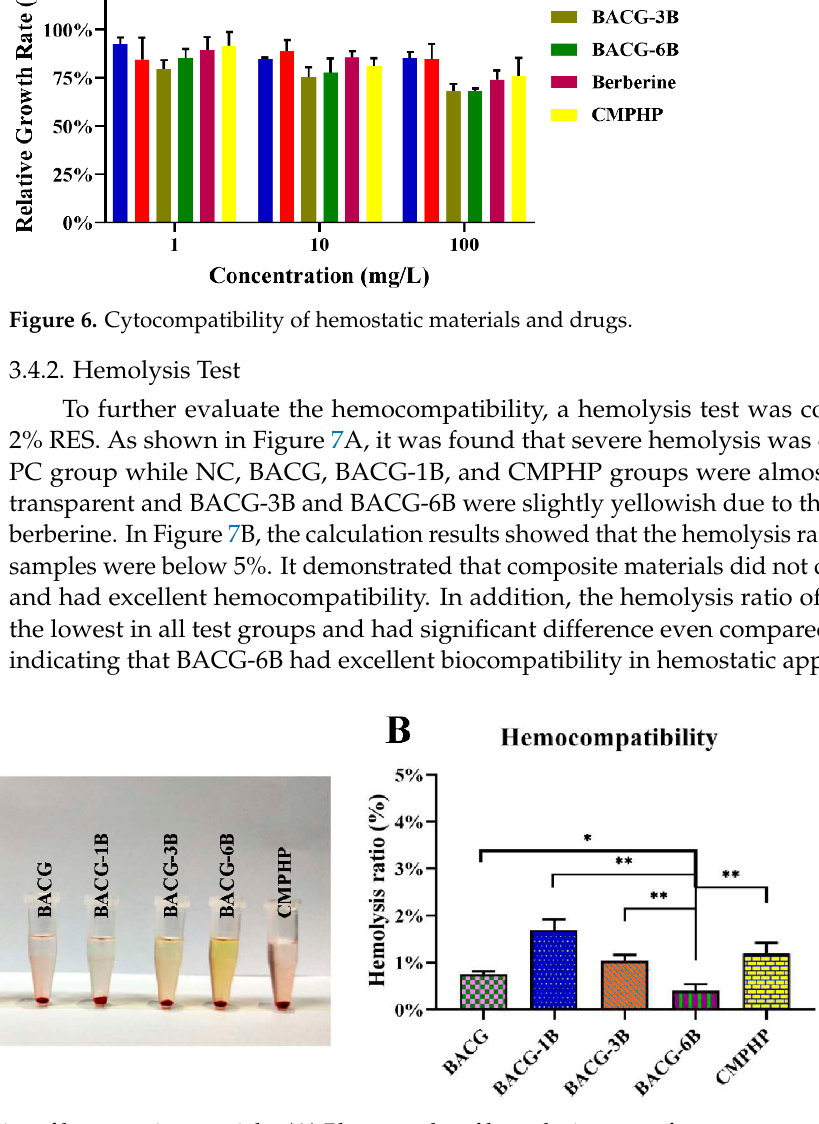
Figure 7. Hemocompatibility of hemostatic materials. ( A ) Photographs of hemolysis assays for test groups and control groups. ( B ) The hemolysis ratio of the corresponding biomaterials. (mean ± SD, ** p < 0.01, * p < 0.05, n = 3).